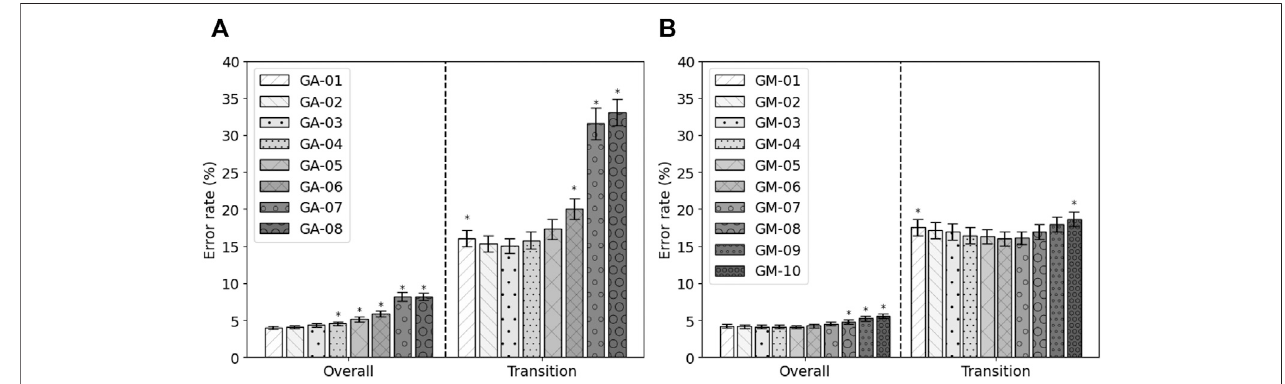
FIGURE3| Averageerrorrates( ± SEM)oftheconstructed GAfeaturesets (A) andoftheconstructed GMfeaturesets (B) on80%oftheMyPredictdataset.Astar indicates a signi fi cant difference compared with the best performing feature set. For the GA feature sets (A) , the best performing feature set was GA-01 for overall error, and in case of transitional errors, this was GA-03. For the GM feature sets (B) , the best performing feature set overall was GM-05, and for transitional errors, this was GM-06.